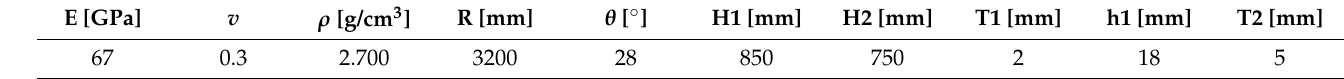
Figure 4. Schematic diagram of the initial design of the cabin door and thin-wall structure. Table 1. The main parameters of cabin door and its surrounding thin-wall structure.